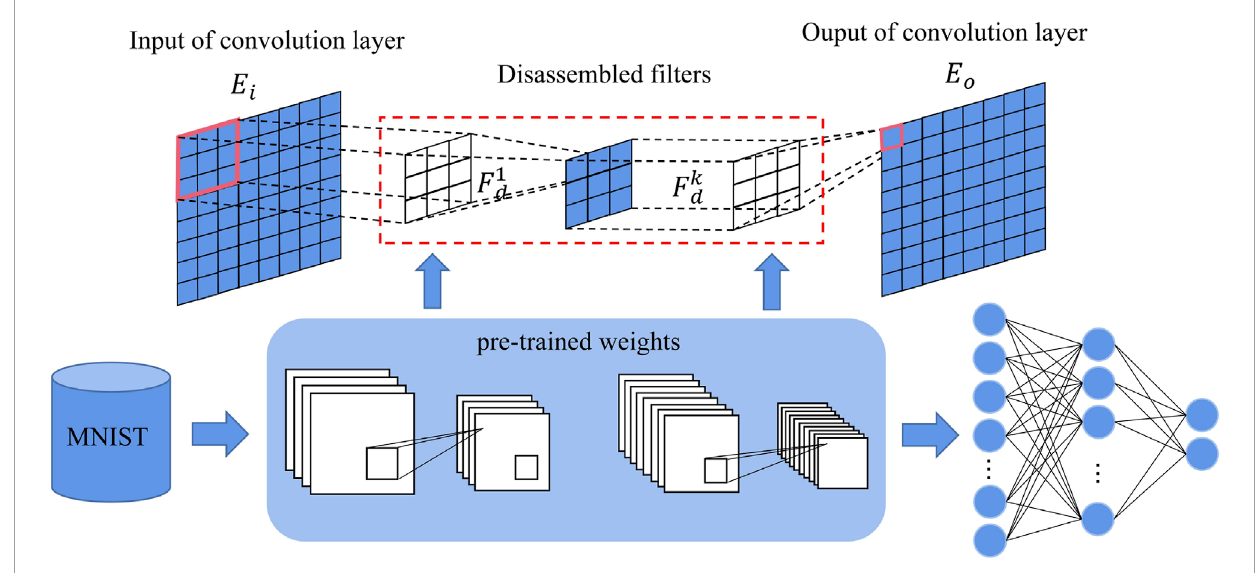
FIGURE 4 Schematic diagram of disassembled filters with initial weights: pre-trained weights from MNIST are used as the initial weights in disassembled filters.